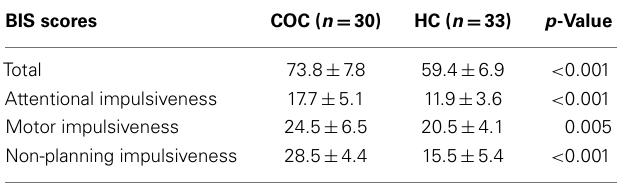
Table 1 |Trait impulsivity scores as assessed using the Barratt Impulsivity Scale (BIS), including the three main dimensions: attentional impulsiveness, motor impulsiveness, and non-planning impulsiveness